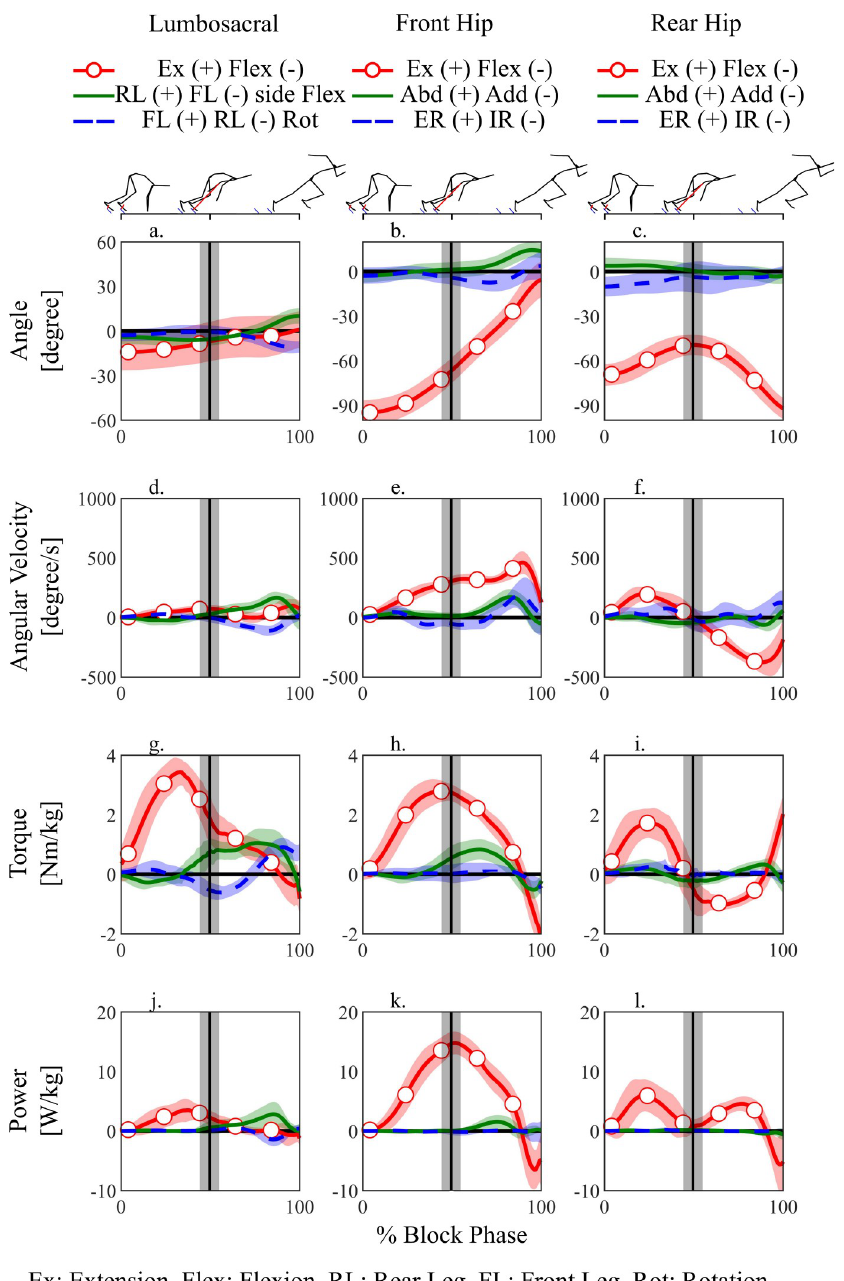
Fig 4. Ensemble averages of the three-dimensional joint angles, angular velocities, torques, and powers at the lumbosacral and both hip joints during the start phase. Vertical lines show the instant of the rear foot